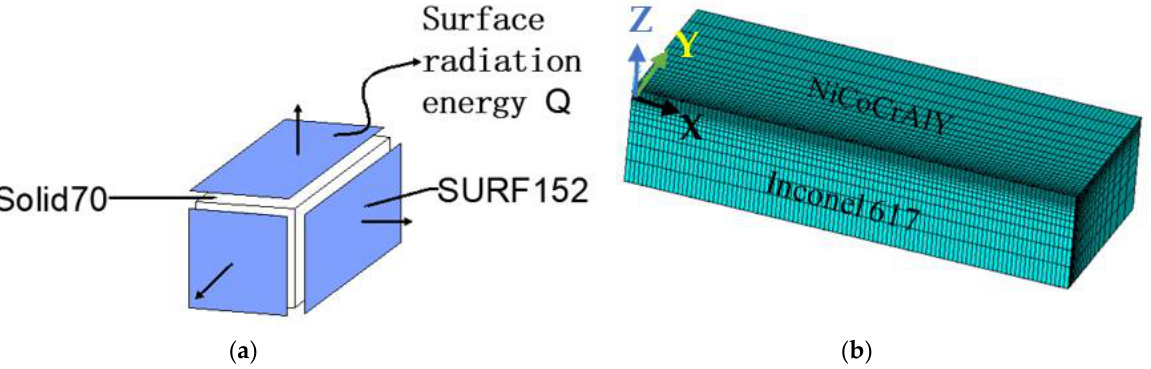
Figure 1. Finite element model: ( a ) unit-type selection diagram and ( b ) grid model. The material thermal property parameters change with temperature and have a large impact on the simulation of the surface molding process. The model thermal property parameters were mainly derived from relevant papers, while the parameters that were not accessible were determined with the help of JMatPro7.0 simulation calculations as well as interpolation and extrapolation methods The thermal properties of the Inconel617 substrate [14,15] are shown in Table 1. The density was 7320 kg/m 3 , and the melting point